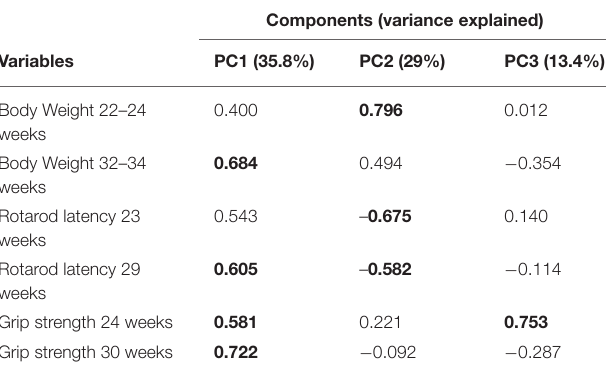
TABLE 1 | Principal component analysis on all mice